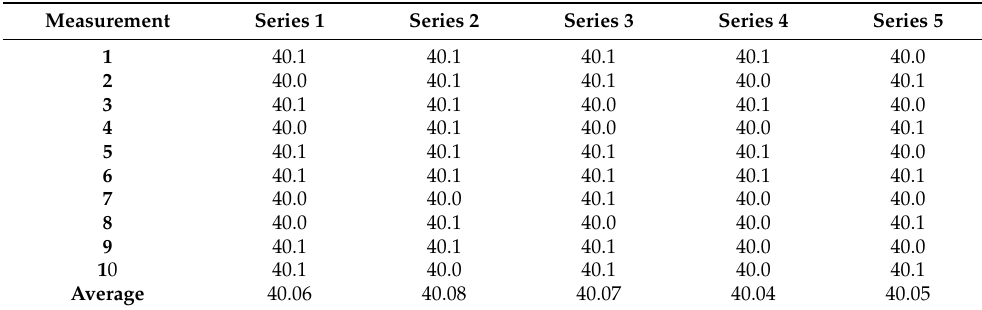
Table 1. Series of 10 measurements performed with the FLUKE 27 multimeter connected to the FLUKE 5500 calibrator for 40 V